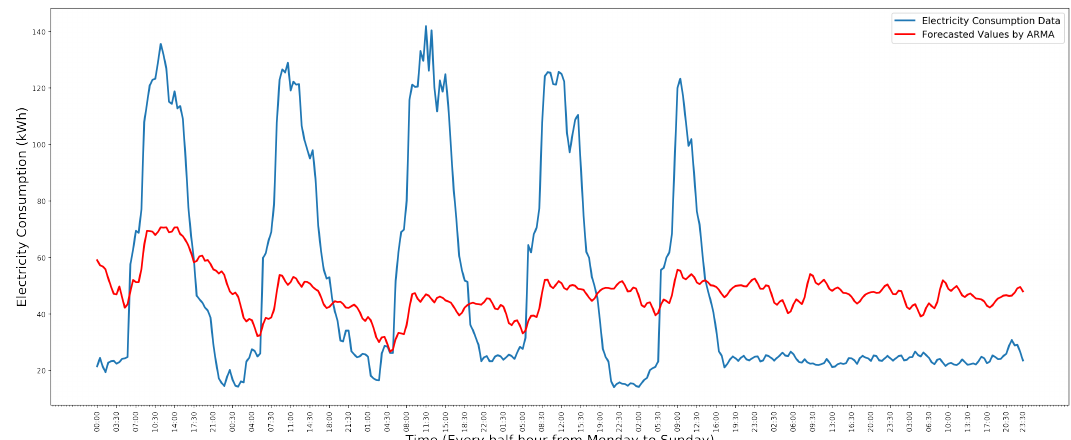
Figure 3. Comparison of one week’s electricity consumption data and the predicted value. Adapted from